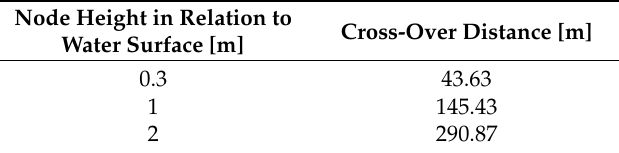
Figure 4. Evaluation of cross-over distance according to heights of the gateway and nodes. Table 2. Two-ray cross-over distance for different node heights.